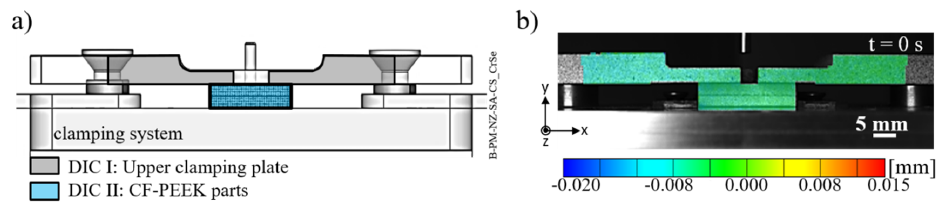
Figure 3. ( a ) Overview of the clamping system showing the areas of analysis for the digital image correlation (DIC) method; ( b ) displacement distribution through the upper clamping plate and the joining parts in the Y-axis direction.